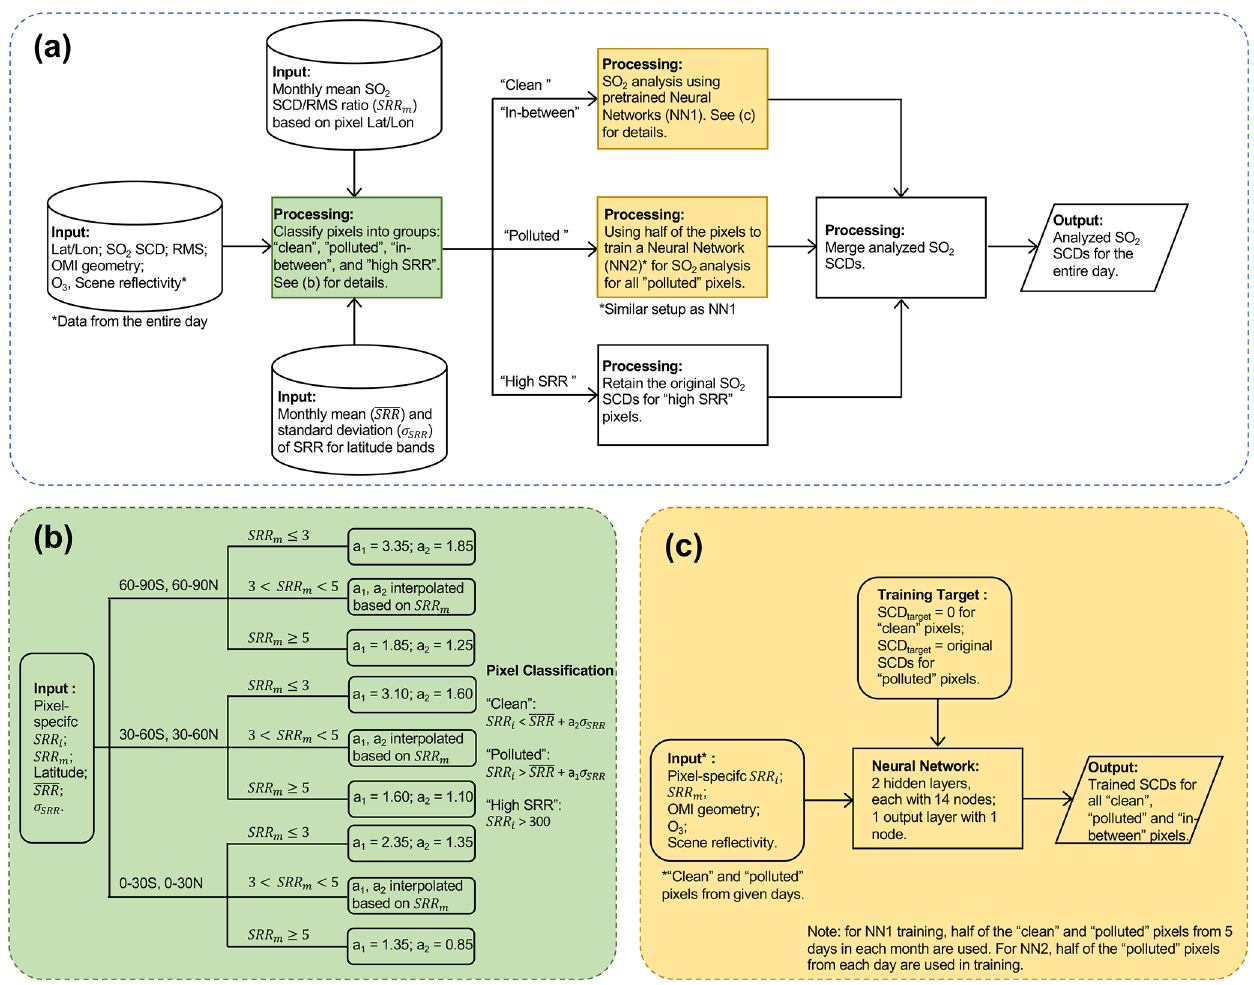
Figure 1. (a) Flowchart of the SO 2 analysis method. (b) Scheme for classification of OMI pixels as “clean”, “polluted”, “in between”, and “high SRR”. (c) Setups of the neural networks for SO 2 SCD